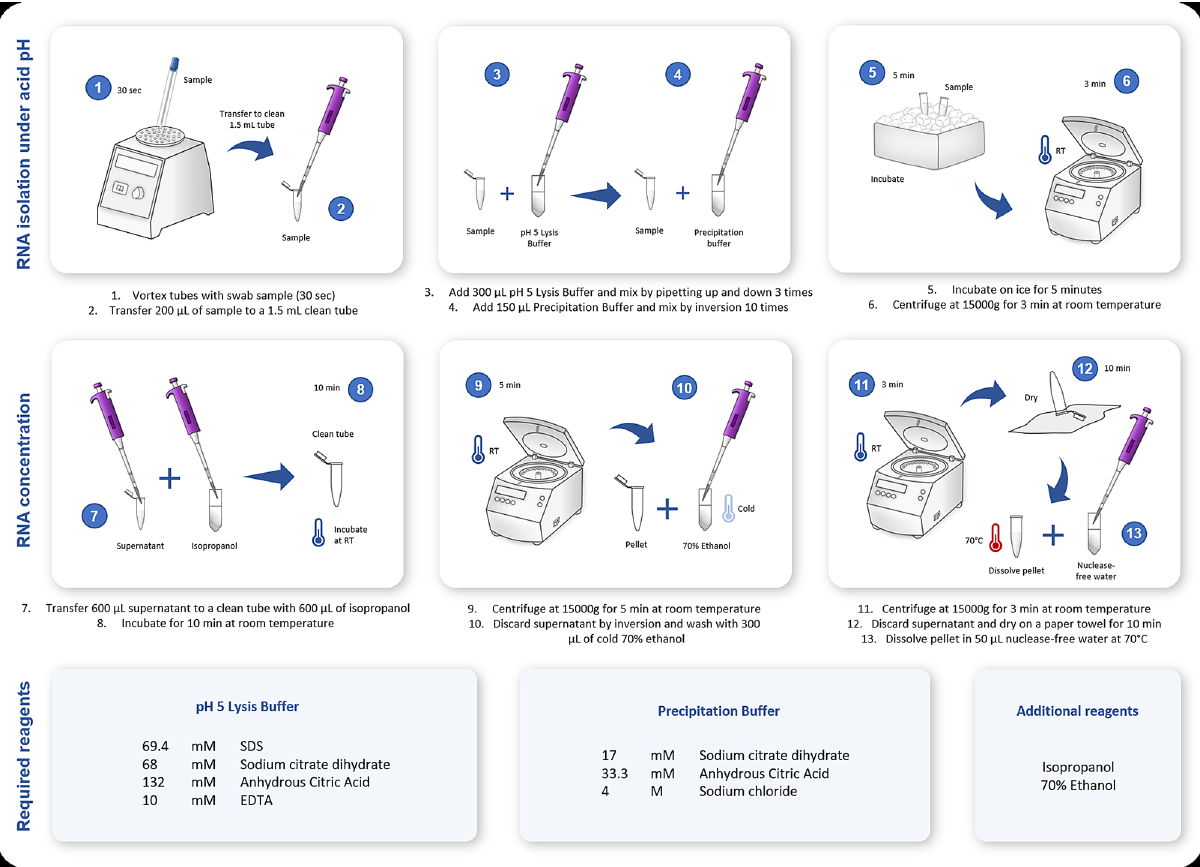
Figure 3. Schematic diagram of the validated acid-pH method for RNA extraction compatible with SARS- CoV2 RT-PCR testing. Steps carried out in the acid pH RNA extraction